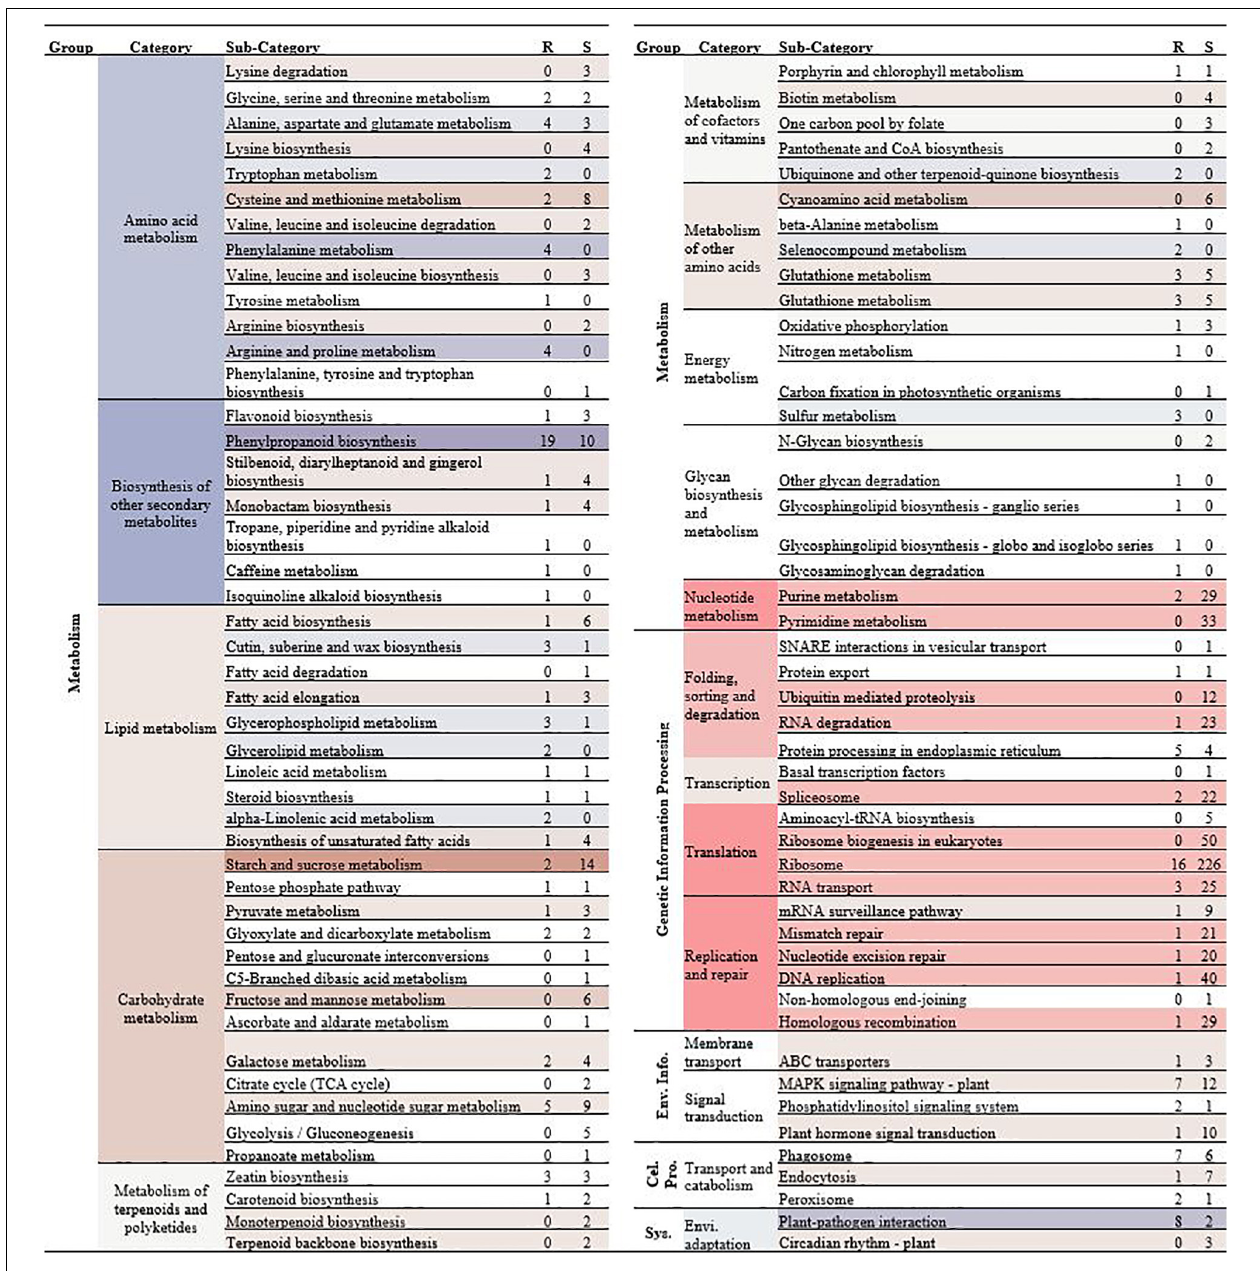
FIGURE 4 | Normalized transcript expression comparison of root (R) and shoot (S) by + Cd vs. –Cd binned into the Kyoto Encyclopedia of Genes and Genomes (KEGG) categories. Genes only represented when DESeq2 p -adjusted value < 0.05 and the fold ratio > 2. Numbers in the category column represent the number of genes showing higher expression in the R or S, and the color shading is based on the difference between the expression in R and S (overrepresented in S, red; overrepresented in R, blue).